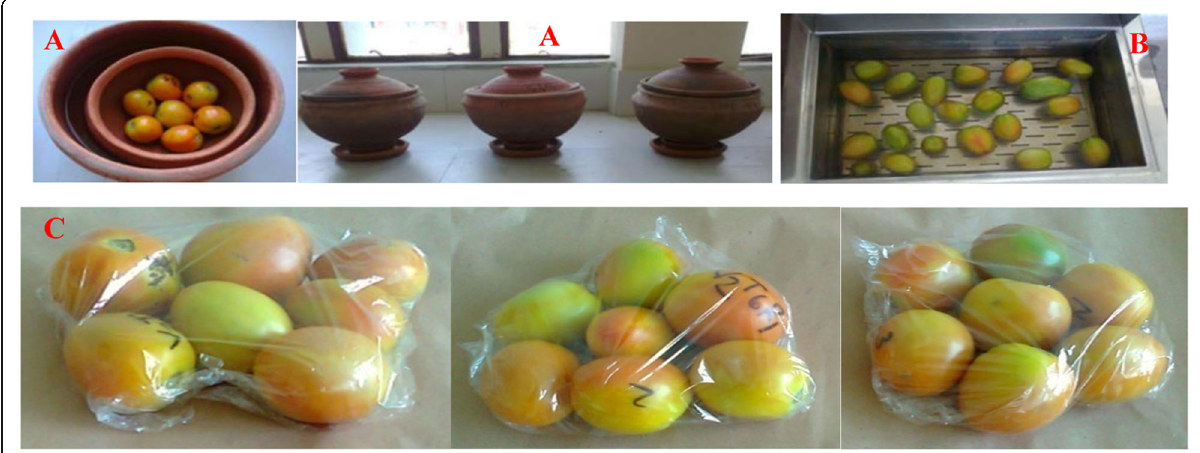
Fig. 1 Ambient condition observation. a Storage of tomato fruit in earthen cooling pot b at water bath for hot water treatment c wrapped with LDPE